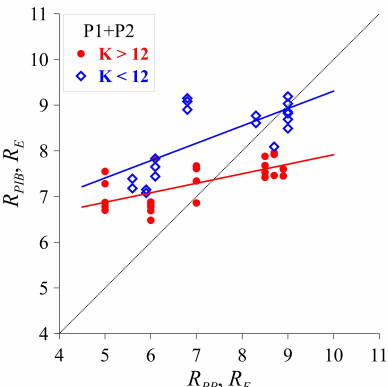
Figure 6. Comparison of mapped IB radial distances (RPIB) with the concurrent plasmapause distances (RPP) for the groups with small K (blue) and large K (red) values. Only the group D1, with the most accurate models, has been analyzed in this